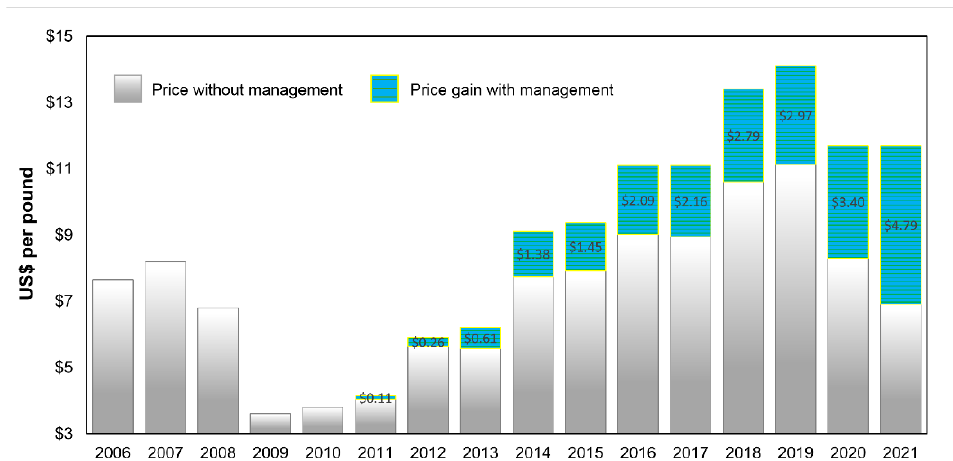
Figure 4. Average price per pound (USD) of parchment coffee without CBB management in Hawaii from 2006 to 2021 and gain in price due to all combined CBB management beginning in 2011.